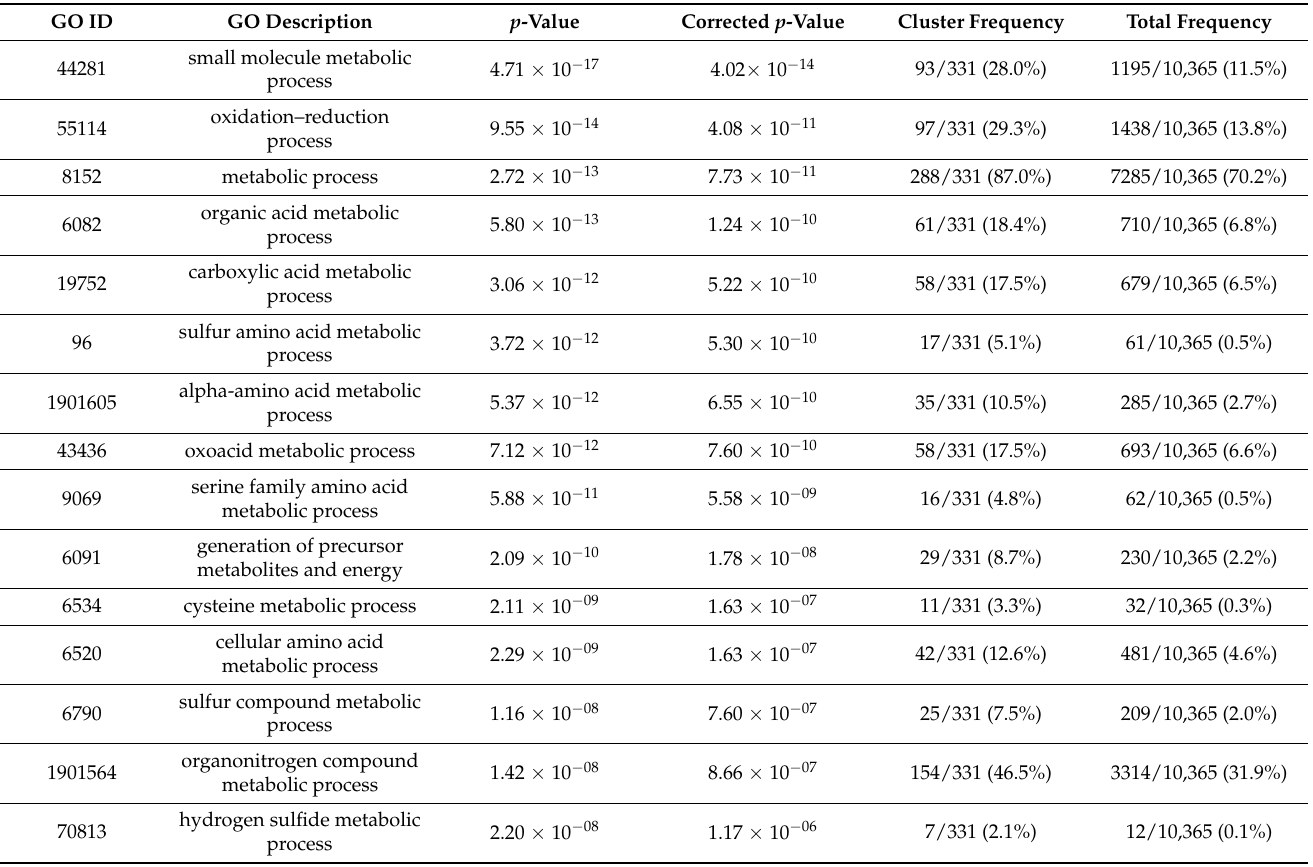
Table 2. Top 15 hits of enriched biological processes in upregulated proteins from T. magnatum in comparison with T. indicum